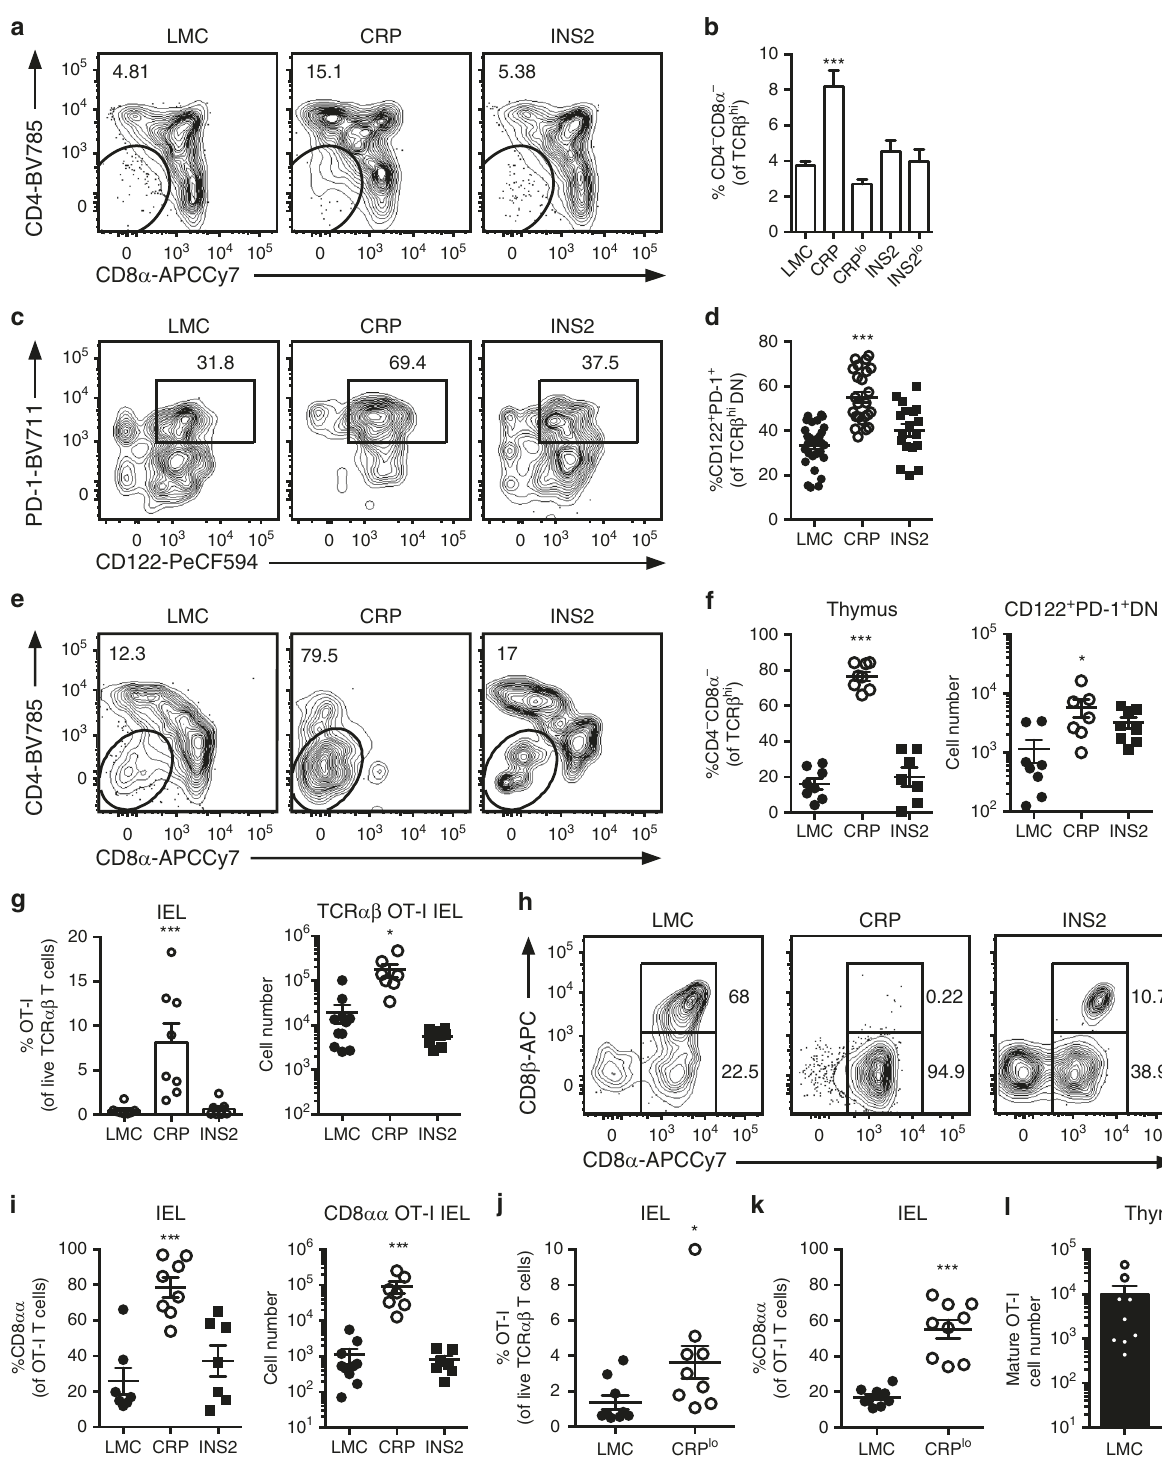
restricted polyclonal T cells (Fig. 5a, b and Supplementary Fig. 5a). Furthermore, naïve CRP Tg mice have a signi fi cant accumulation of H-2K b -OVA-speci fi c TCR αβ IEL in the small intestine as well as a higher proportion of TCR αβ + CD8 αα IEL (Fig. 5c – e). For MHC class II-restricted model antigen-speci fi c cells, we observe that the relative number of I-A b -gp66-speci fi c CD4 + T cells is lower in both naïve CRP and INS2 Tg mice as compared to their respective LMC counterparts (Fig. 5f, g and Supplementary Fig. 5b), while only the INS2 Tg mice have an